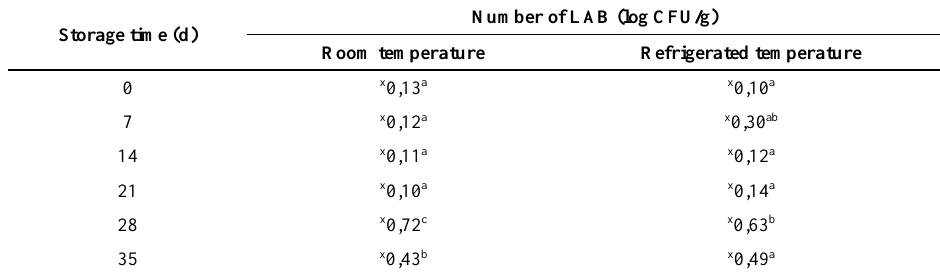
Table 8. The amount of reduction in strain B1295 microencapsulated with CMFH from OPT at different temperatures for 35 days storage and treated with bile Number of LAB (log Storage time (d)